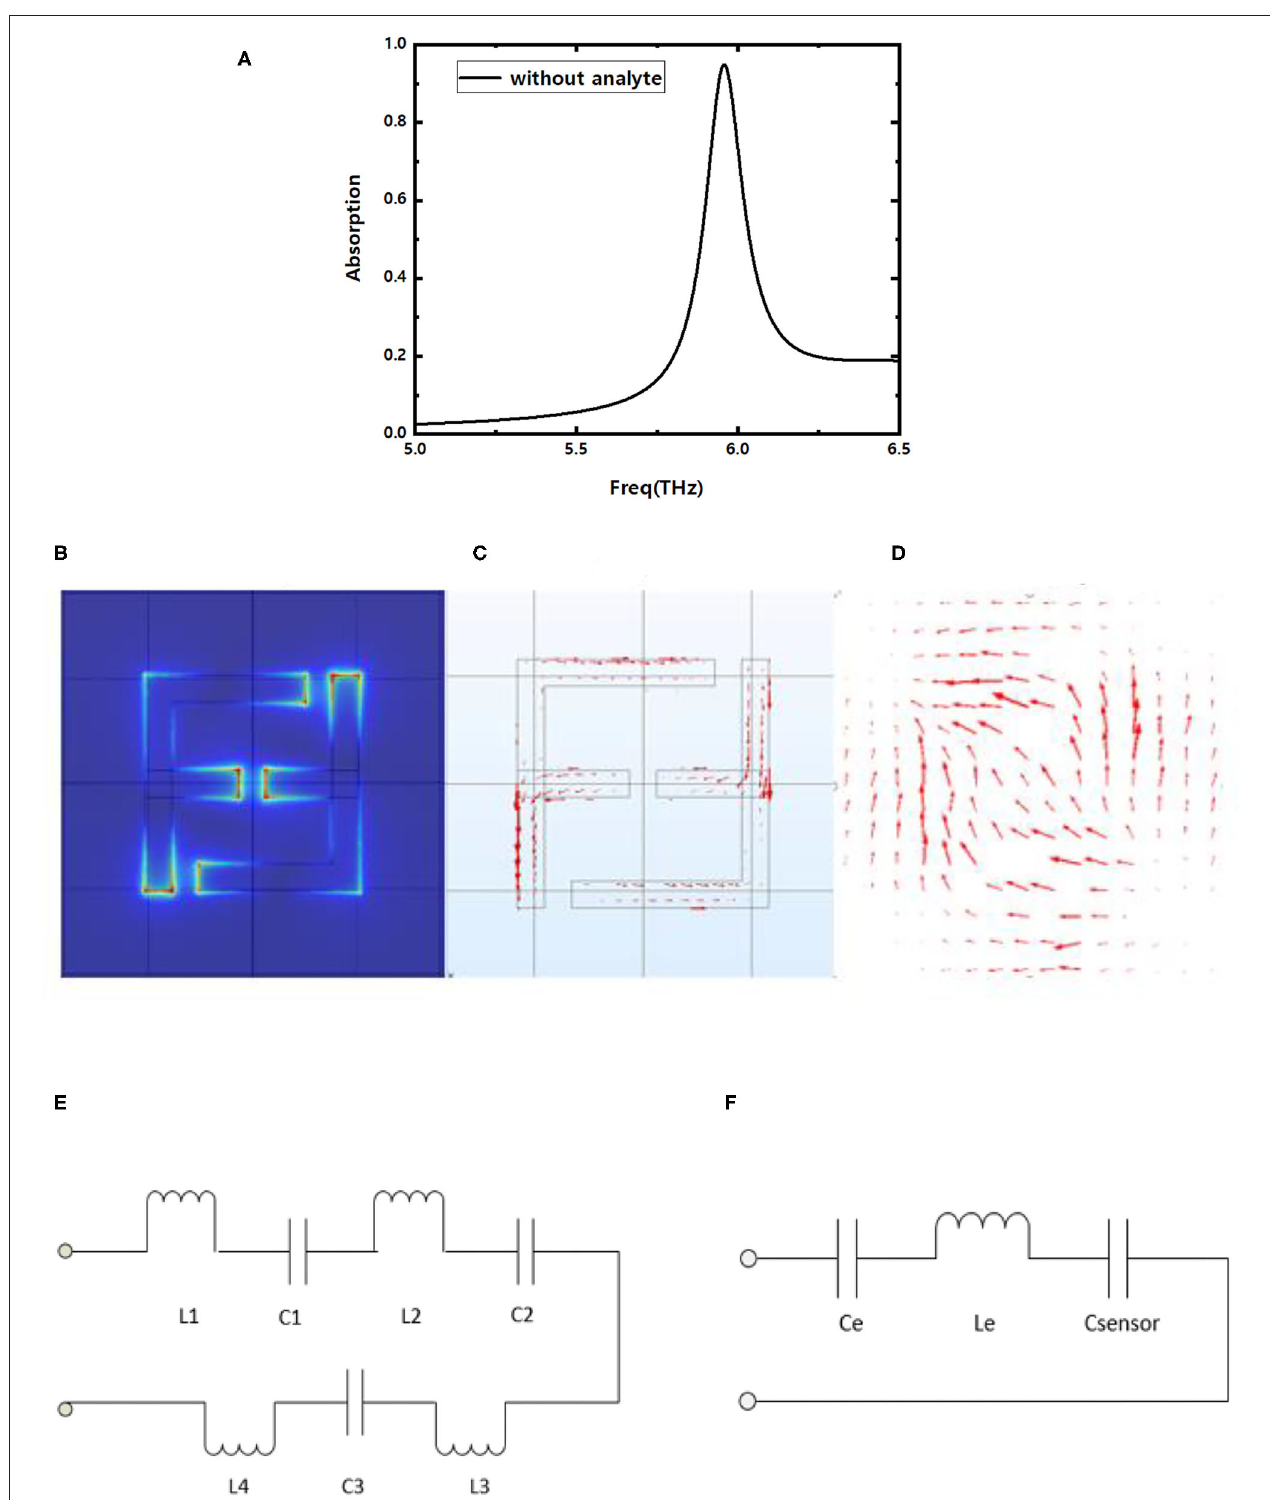
FIGURE 2 | (A) Absorption spectrum of CDFMR at 5.95 THz without analyte; (B) electric field distribution, (C) upper surface current distribution on the resonators and (D) bottom surface current distribution on the metal base plate at 5.95 THz resonance frequency; (E) equivalent circuit model of F-shaped resonators; (F) simplified equivalent circuit model of